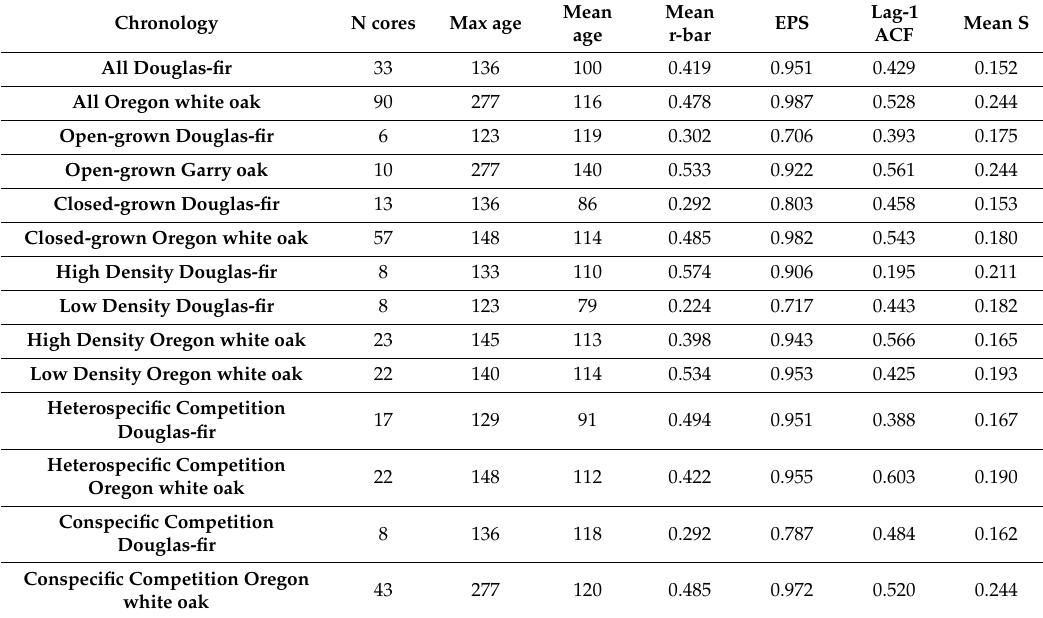
Table 1. Selected properties of the tree-ring chronologies developed for comparison to the Palmer Drought Severity Index (PDSI) data and to each other from Rocky Point, British Columbia,